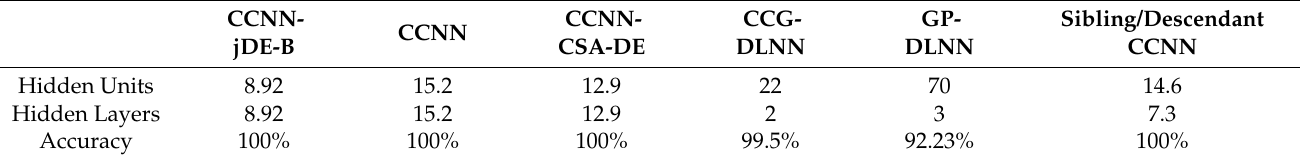
Table 1. The simulation results of each algorithm on the two spirals classification